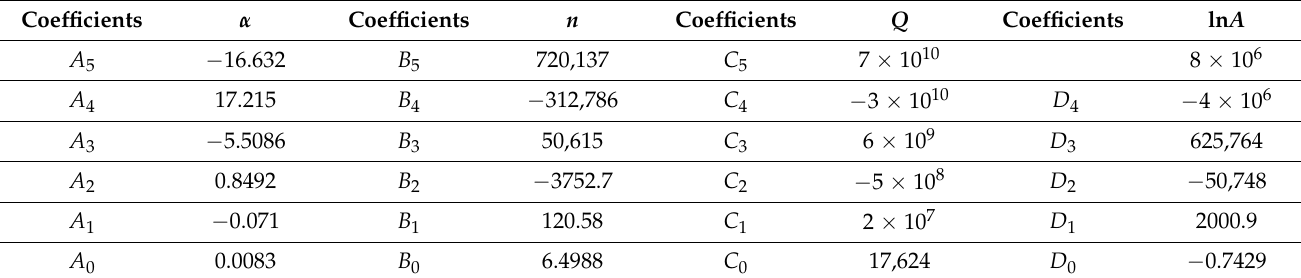
Table 3. Polynomial coefficient of α , n , Q , ln( A ) for USIBOR ® 1500.